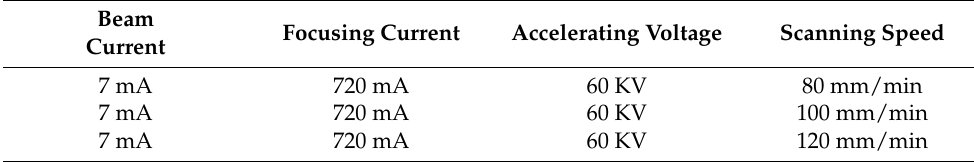
Table 2. Electron beam scanning process